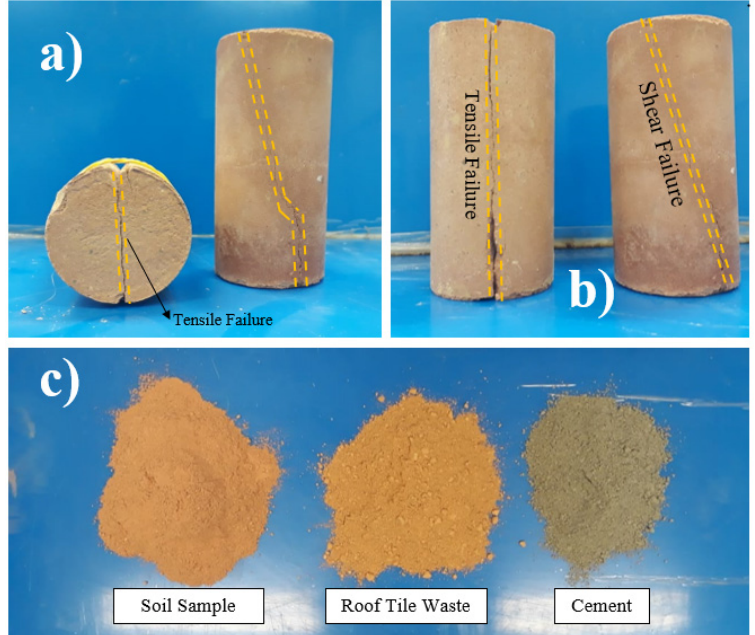
Figure 3. Details of raw materials and specimens: ( a ) Specimens after splitting tensile (front tensile failure) and unconfined compressive strength tests; ( b ) Specimens after splitting tensile (longitudinal tensile failure) and unconfined compressive strength tests (longitudinal shear failure); and ( c ) colors and appearances of raw materials (soil sample, crushed roof tile, and cement).